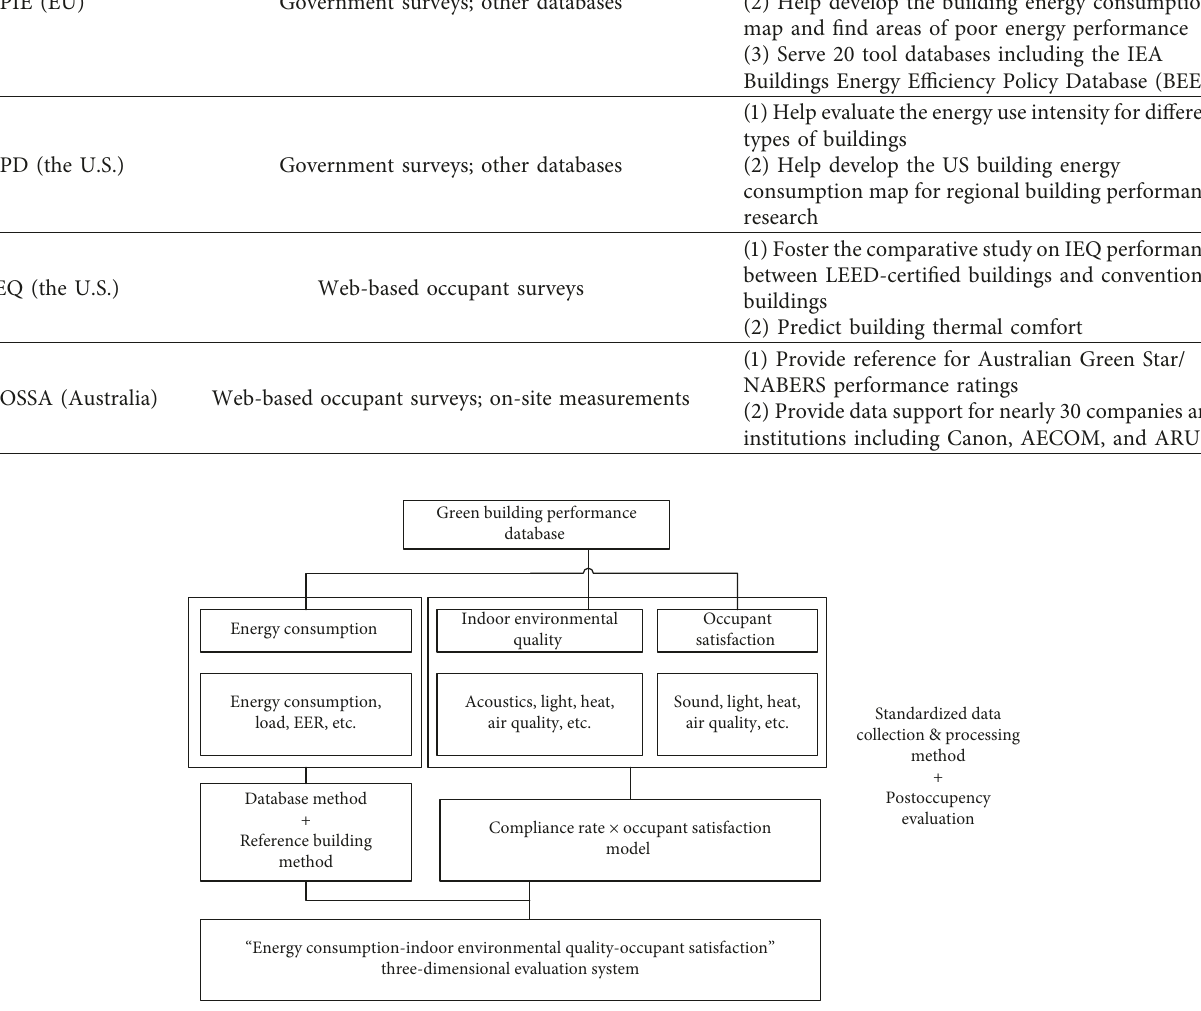
Figure 3: Framework of green building performance database for Zhejiang